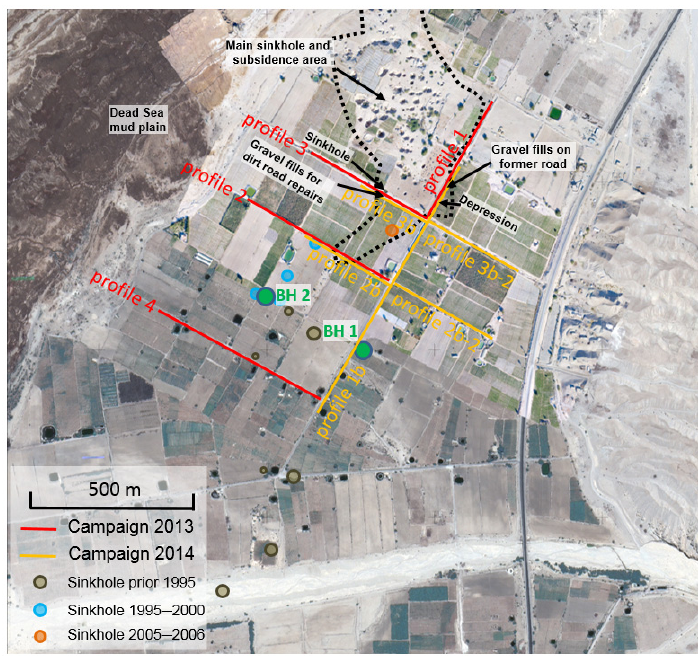
Figure 4. Map of the shear wave reflection seismic profiles acquired in 2013 (red lines) and 2014 (yellow lines). Green circles denote the locations of the boreholes made in 1994 (according to the report of El-Isa et al., 1995). Older refilled sinkholes are denoted by brown circles (after El-Isa et al., 1995), blue circles (after Sawarieh et al., 2000), and the orange circle (after Bodet et al., 2010). The dotted black line marks the main sinkhole and subsidence area after Al-Halbouni et al.